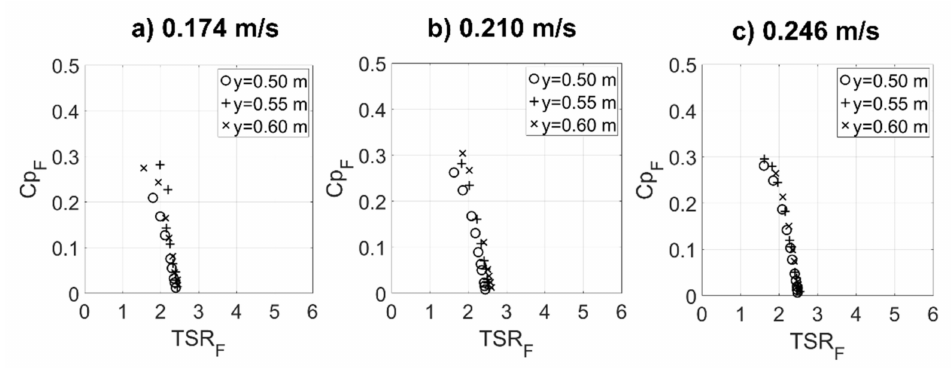
Figure 12. Cp F vs. TSR F curves for the three water velocities tested using the accelerator device under open-field